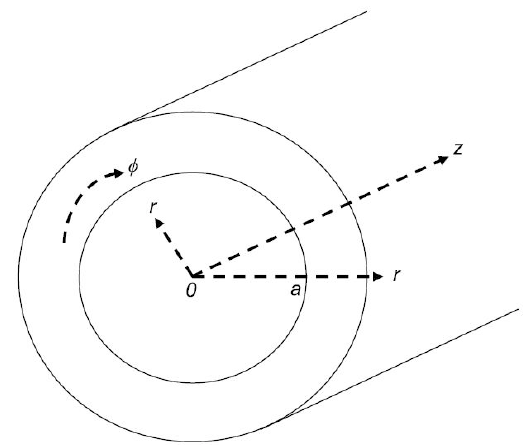
Figure 1: A circular